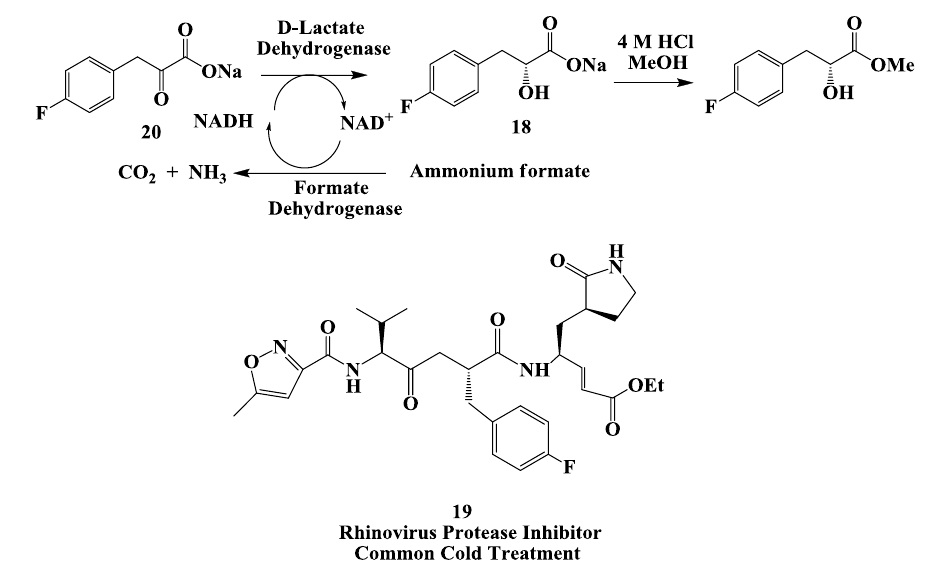
Figure 5. Rhinovirus protease inhibitor: Enzymatic process for the preparation of ( R )-3-(4-fluorophenyl)-2-hydroxy propionic